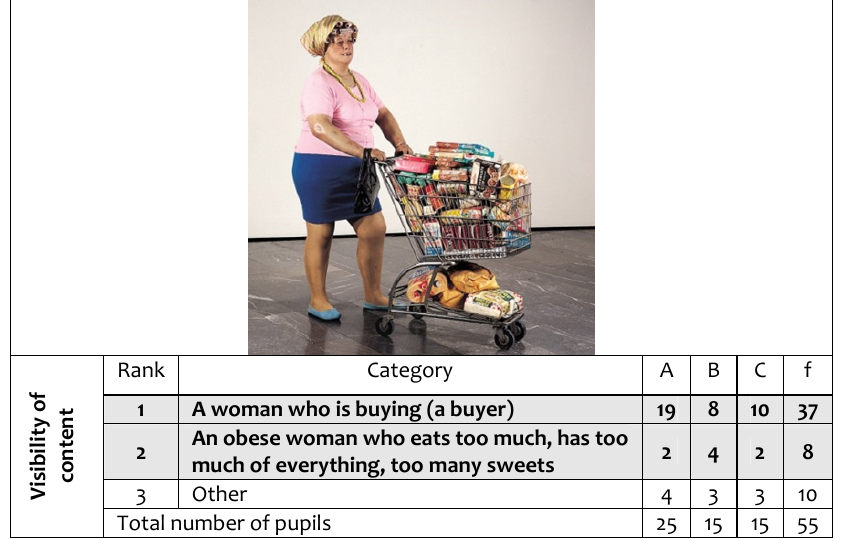
Table 17: Ranking order of answers regarding the visibility of the content of the seventh case (Duane Hanson, Supermarket Lady, 1969).